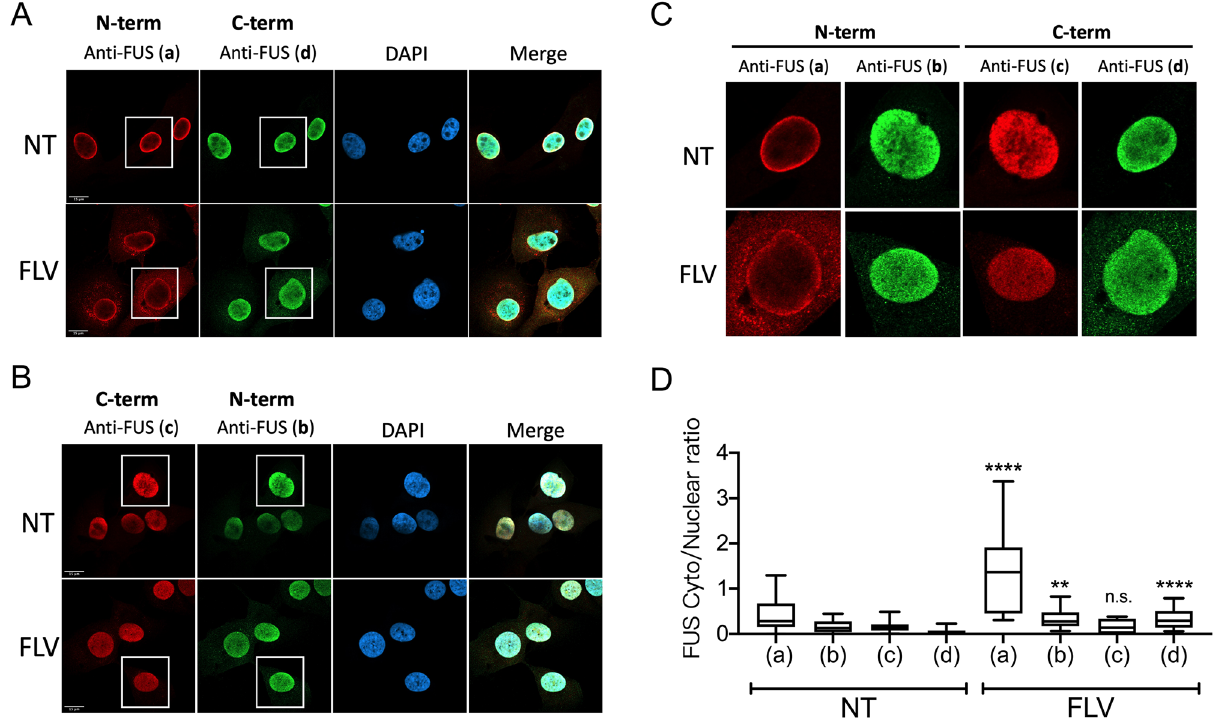
Figure 2. Transcriptional inhibition induces FUS cytoplasmic translocation demonstrated by staining with multiple antibodies. ( A , B ) U87 cells were treated with flavo (1 uM, 4 h) followed by fixation and FUS IF. Each of the two anti-FUS antibodies recognizing the N-terminus ( a , b ) were mixed with one of the two anti-FUS antibodies recognizing the C-terminus ( c , d ) as indicated for FUS IF. The primary anti-FUS antibodies were distinguished by fluorescence-conjugated secondary antibodies recognizing different species (red: mouse; green: rabbit). Final concentration of each primary antibody was 2 ug/ml. ( C ) Enlarged images of insets indicated in panel A and B. ( D ) Cytoplasmic to nuclear FUS ratios were compared between flavo-treated (FLV) and untreated control (NT) cells using anti-FUS N-terminus and C-terminus antibody fluorescent intensities. n = 13–26 cells were analyzed in each experimental condition. (** p = 0.0088, **** p < 0.0001) Mann–Whitney U -test. Scale bars = 15 µm.